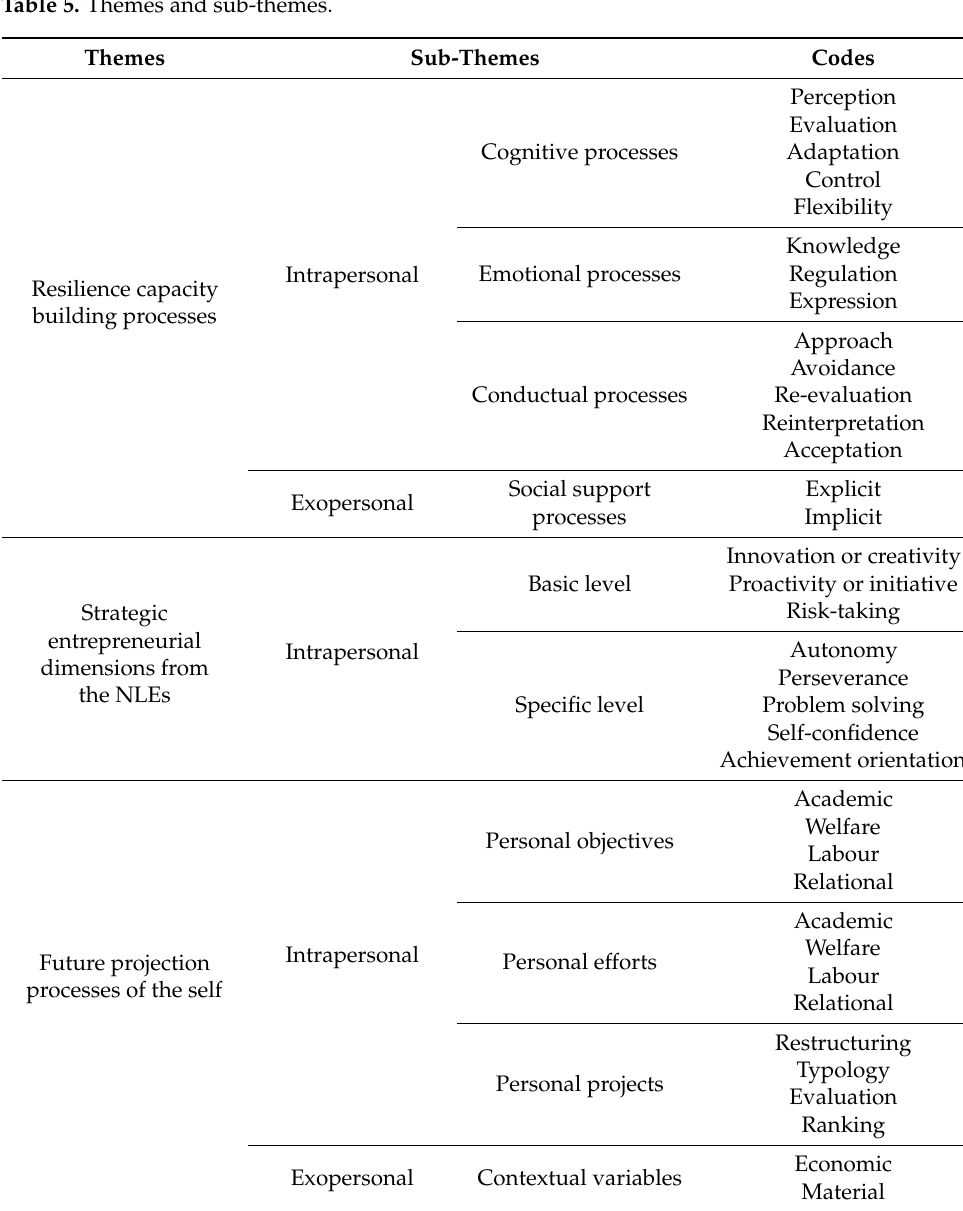
Table 5. Themes and